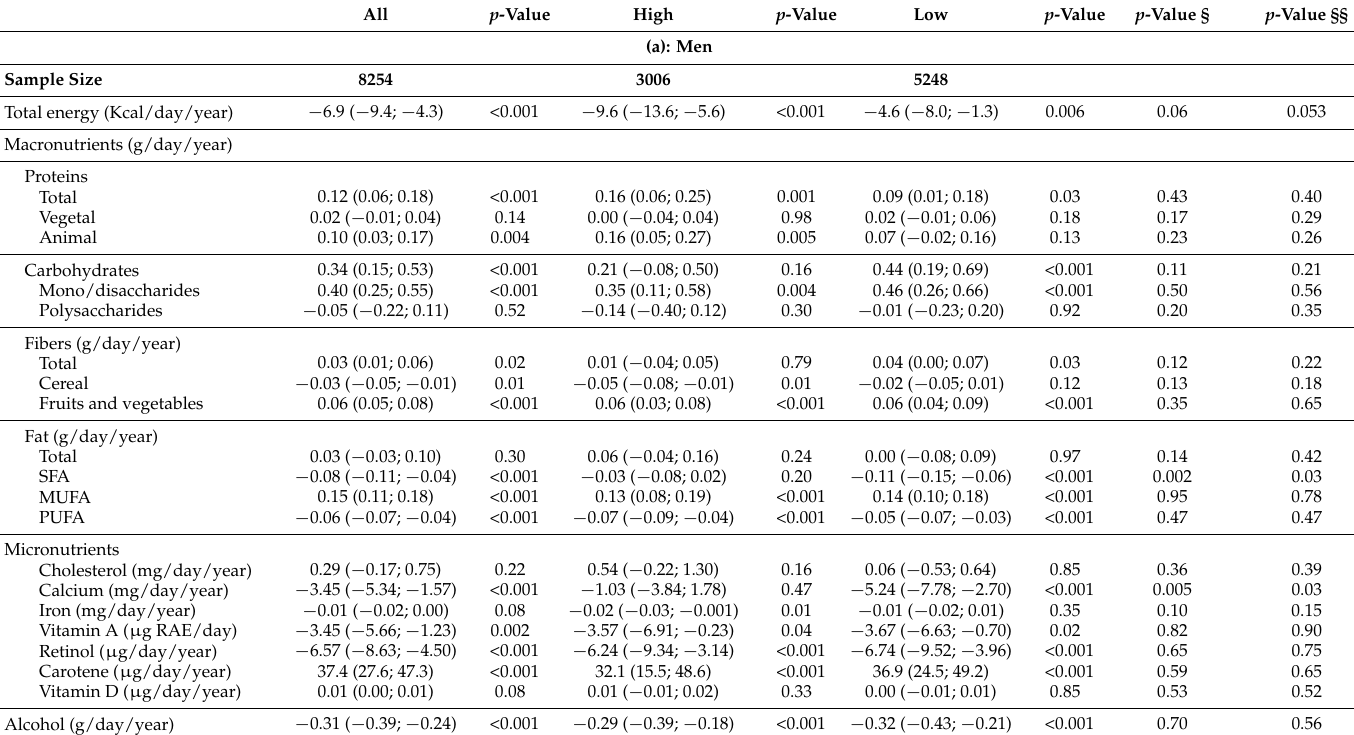
Table 3. Trends in total energy and nutrient intakes in the “Bus Santé” study, Geneva, Switzerland, 1993–2012, overall and according to high or low educational